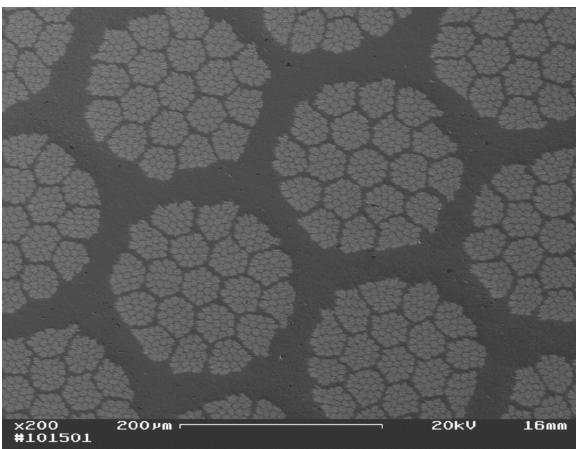
Figure 3. Cross section of the Cu15 vol.Nb. R = 1.27x10 7 X. Magnifi- cation: 200 X. MEV.